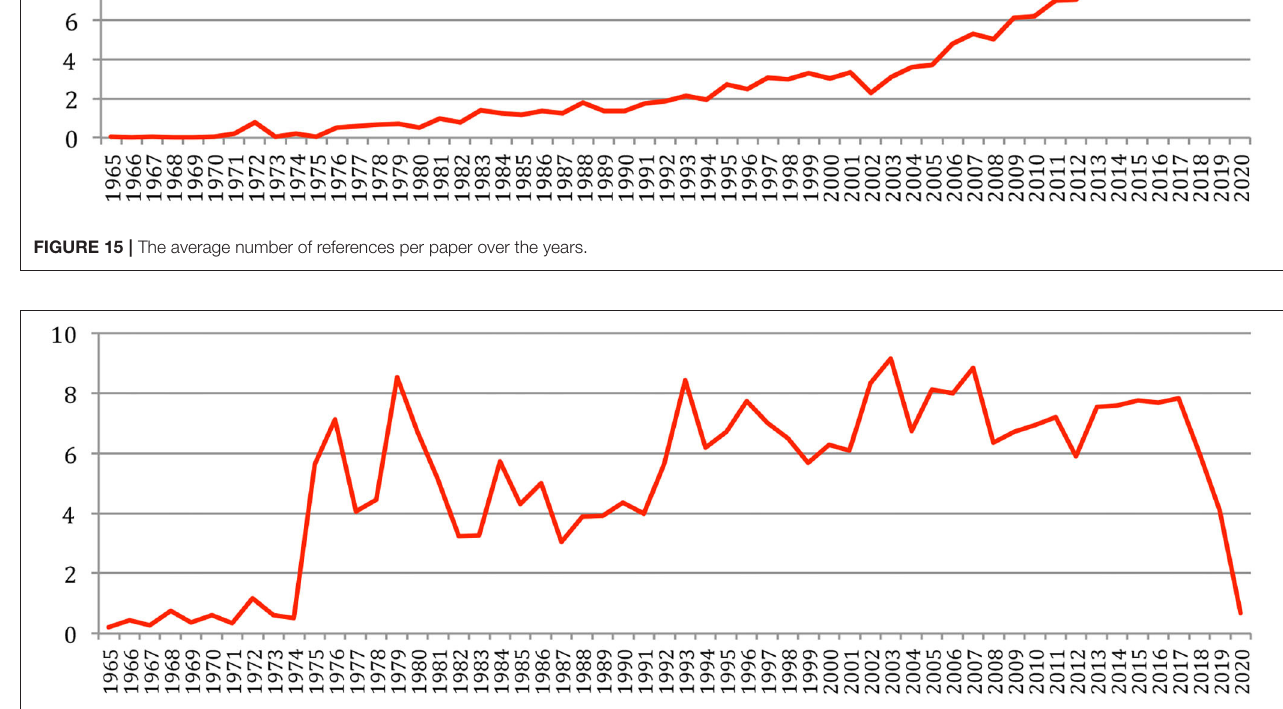
FIGURE 16 | The average number of citations of a paper over the